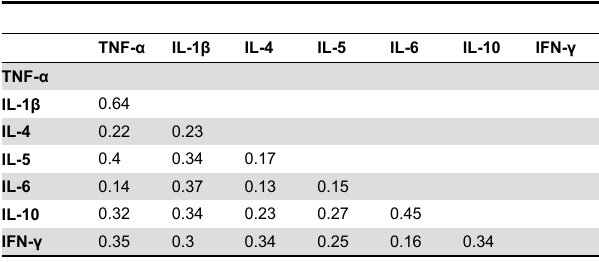
Table 3. Correlation between cord cytokine levels (Spearman’s rank correlation).